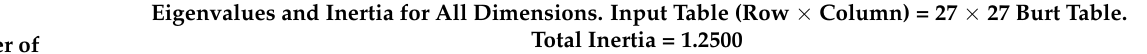
Table 5. Quantitative characteristics of Burt